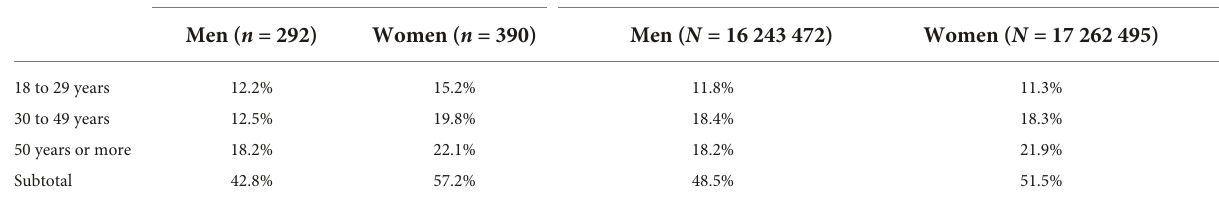
TABLE 1 Comparison of the distribution by sex and age of the sample of participants with the distribution of the Spanish population (Sanz and García-Vera, 200 9, p. 134). Age Sample of participants Population in Spain (Instituto Nacional de Estadística [INE], 2004)